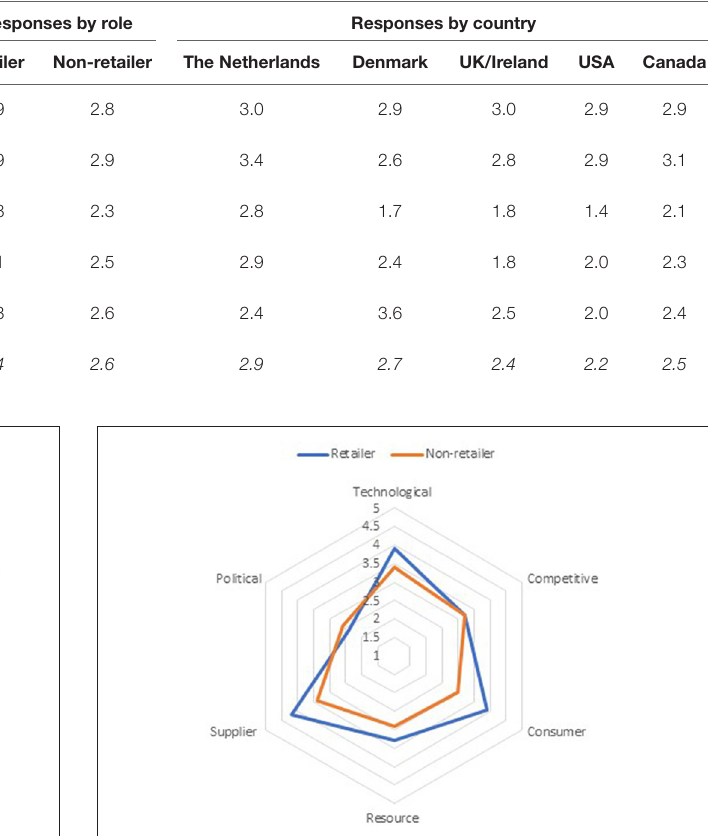
suitability of AMS. Farmers in early adopting countries (e.g.,